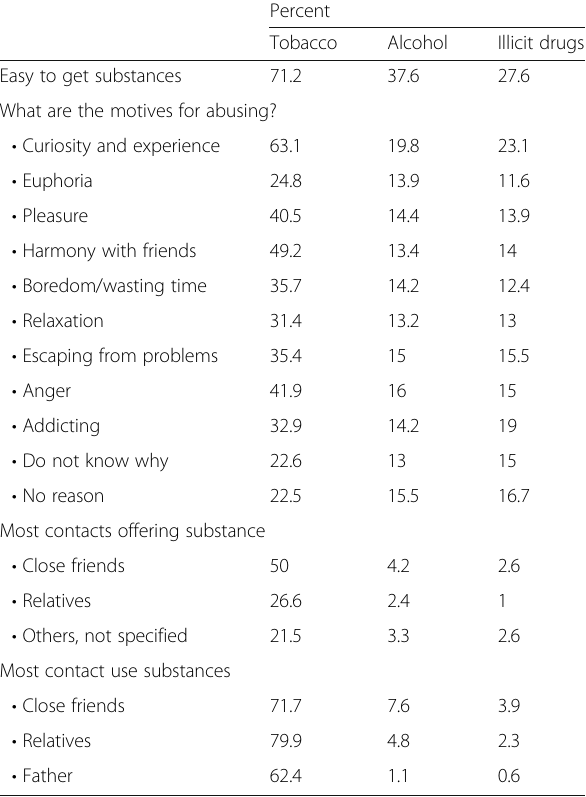
Table 5 Motivations or reasons behind substance use among students